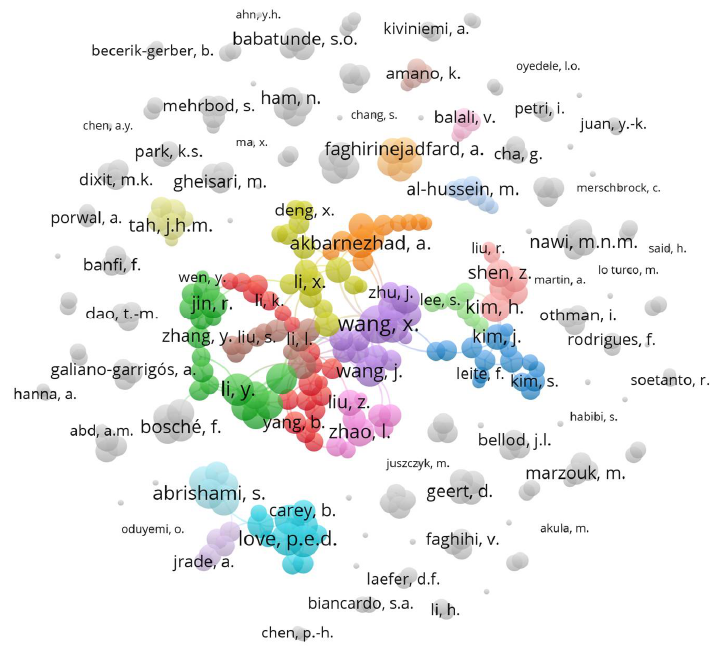
Figure 3. Visualization of co-authorship network for all 337 co-authors, out of 2009 co-authors with a minimum of two articles, using the full counting technique based on CCM, including 770 articles. Note: the total link strength was used for